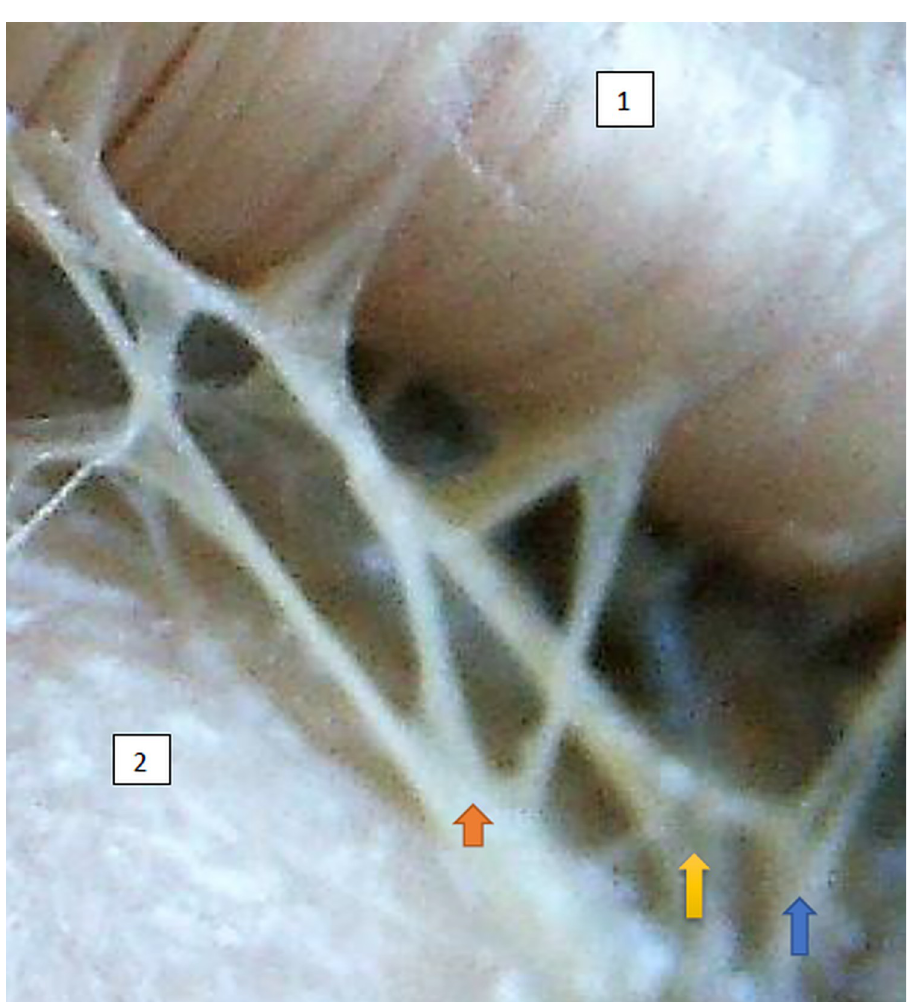
Fig 11. Superior gluteal nerve, bushy type, horizontal–oblique course, the net with variform meshes, morphological age 169–25–VII,V–tub 200, V–pl 294,mass 690, male sex, magnification 20x. Figs 10 and 11 are taken from both sides of the same specimen and are evidence of symmetry in the type of innervation., 1– gluteus medius muscle, 2– gluteus minimus muscle, red arrow–branch to gluteus medius muscle, yellow arrow–branch to gluteus minimus muscle, blue arrow–branch to tensor fasiae latae